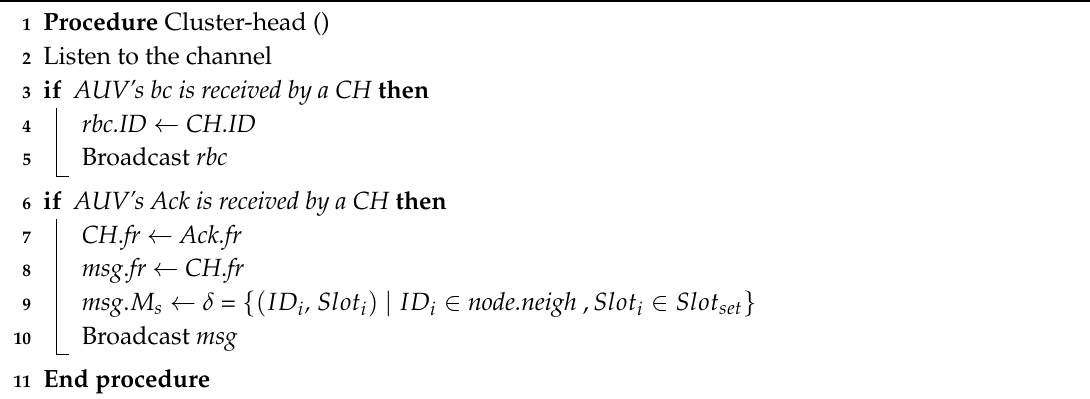
Algorithm 2: Cluster head operation during the discovery phase